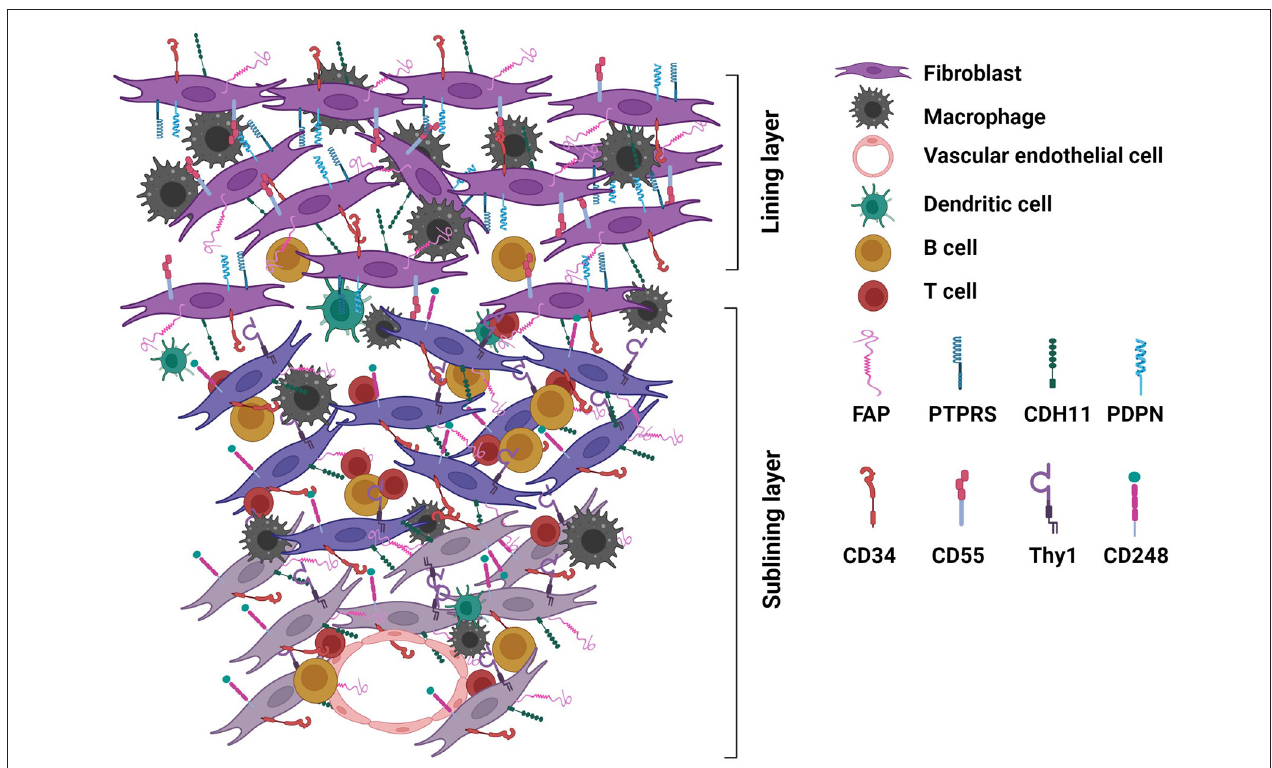
FIGURE 1 | Rheumatoid arthritis (RA) synovium highlighting fibroblasts with surface protein expression. Expansion of fibroblasts substantially contributes to the hyperplasia of RA synovium. Fibroblasts interplay with immune and inflammatory cells to perpetuate inflammation and invade cartilage and subchondral bone leading to joint destruction. Subpopulations of fibroblasts disperse in the lining and sublining layers of the synovium. Distinct profiles of surface proteins expressed by sublining and lining fibroblasts are highlighted here with relevance to fibroblast targeted therapies. Sublining fibroblasts express Thy1 (CD90) and CD248, while lining fibroblasts express CD55, podoplanin (PDPN), and protein tyrosine phosphatase receptor sigma (PTPRS). CD34, cadherin (CDH)-11 and fibroblast activation protein (FAP) are expressed by both sublining and lining fibroblasts [detailed summary of protein expression by different subpopulations of RA synovial fibroblasts is described in Nygaard and Firestein’s review (